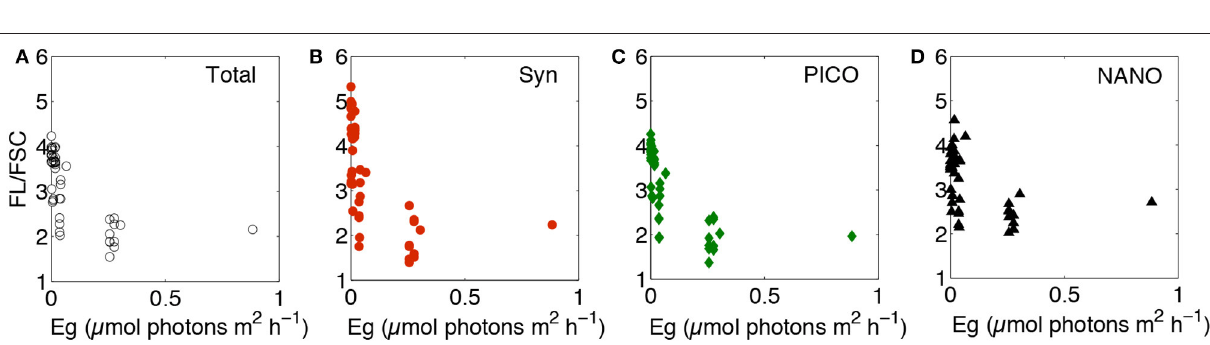
FIGURE 8 | Fast Rate Repetition fluorometry (FRRf) nighttime averages of (A) Fo and Fm (left y-axis) and HPLC Chl a (right y-axis), (B) Sigma-PSII (left y-axis) and Fv:Fm (right y-axis) and (C) Sigma-PSII (left y-axis) and T 0 normalized RCII:FSC. Error bars represent 1 standard deviation.